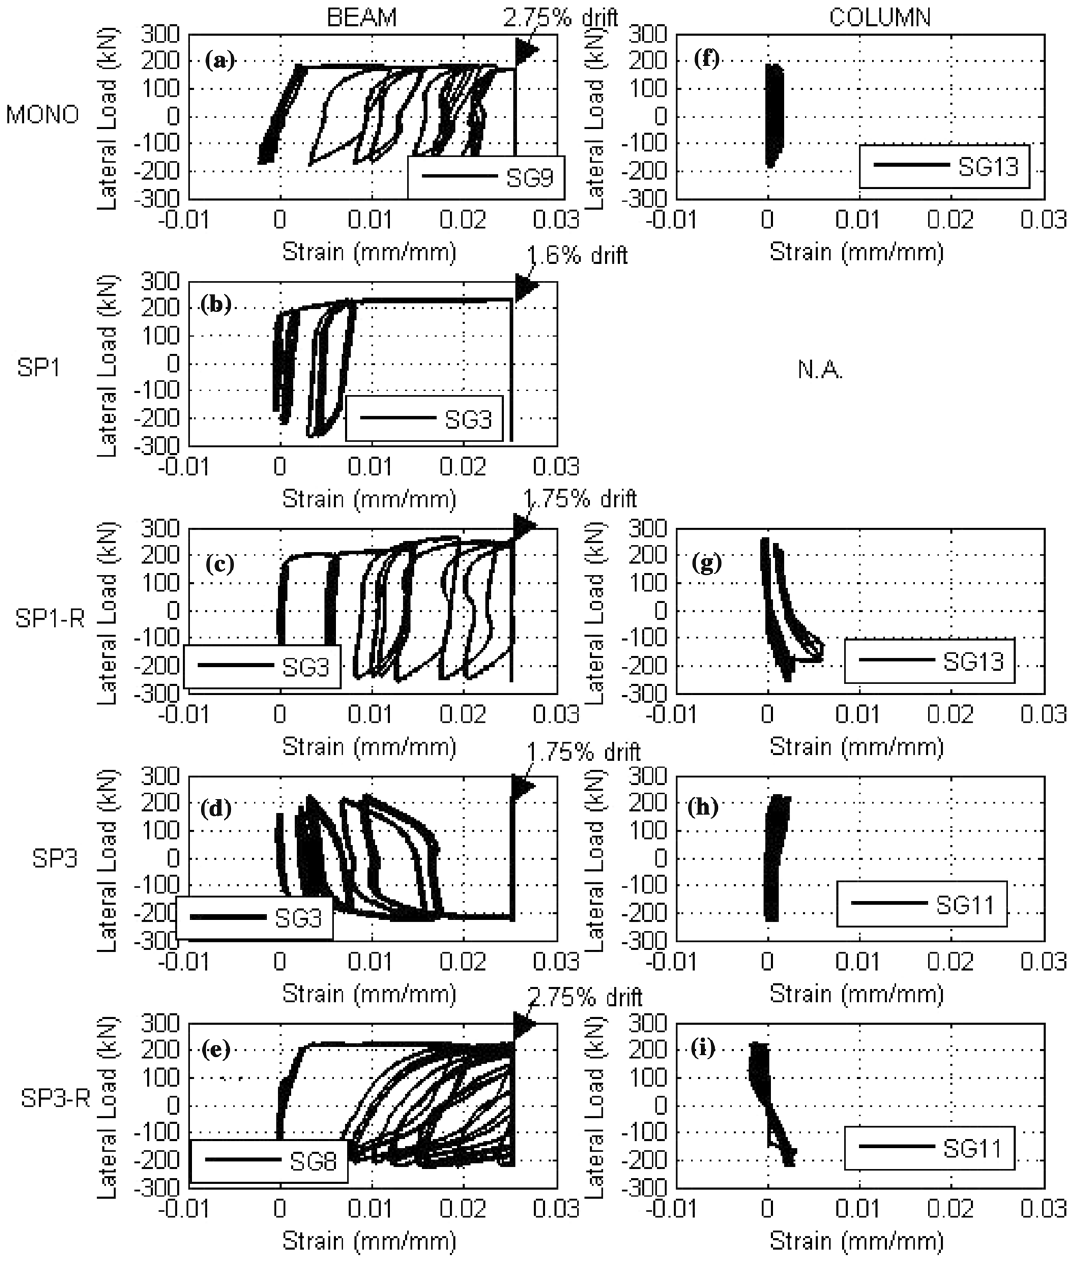
Fig. 18 Measured longitudinal bar strains of beams and columns of connection specimens.